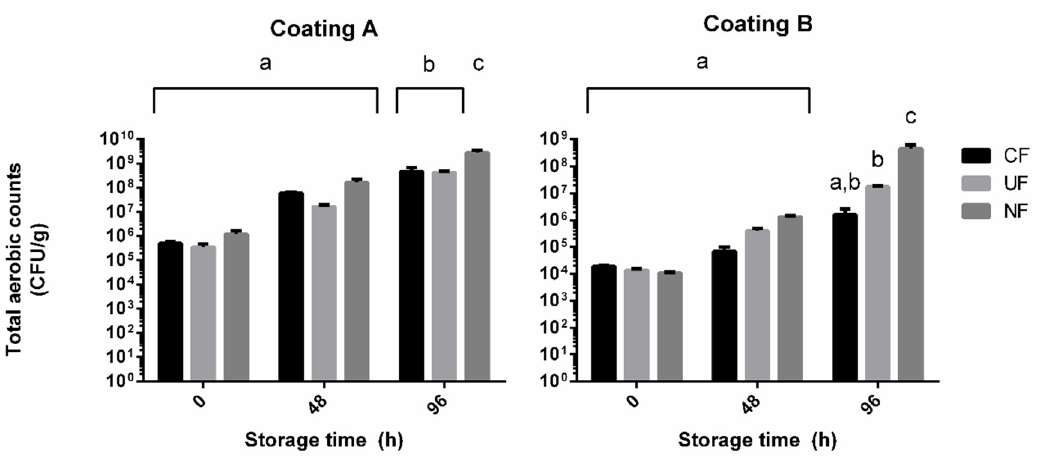
Figure 5. Total mesophile aerobic organisms counts during storage of poultry samples wrapped in coated PP films (CF), uncoated PP films (UF), and no film (NF). Coating A = 5 wt% P. dioica extract and 7.5 wt% PVA. Coating B = 1 wt% P. dioica extract, 1 wt% PVA, and 17 wt% gelatine. Results are presented as averages (n = 4) and standard deviation. a, b, and c represent statistically identical counts with p < 0.001, determined by Tukey’s HSD.